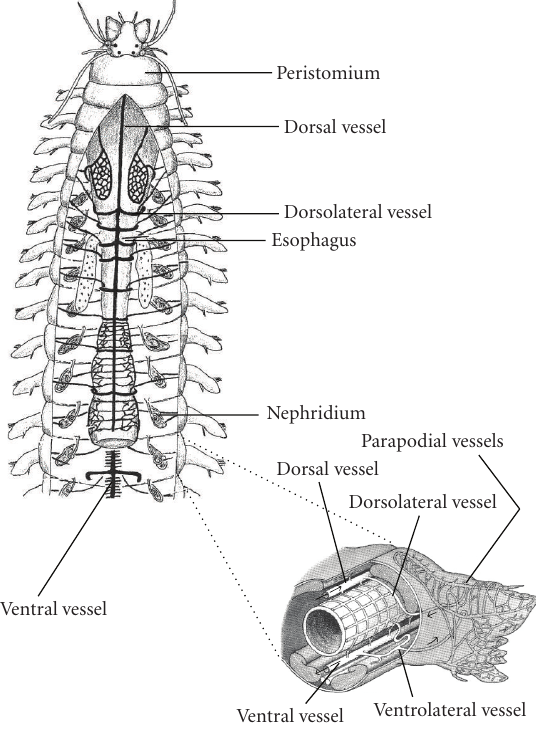
Figure 3: The fine structure of the annelid (Polycheata) circulatory system. The center diagram shows the general anatomy of the segmentally based vascular system. A cross-section through the body wall of the polycheates is shown on the left with body wall, epidermal, and coelomic vessels identified. The highly branched parapodial vasculature is outlined on the right (adapted from [11,